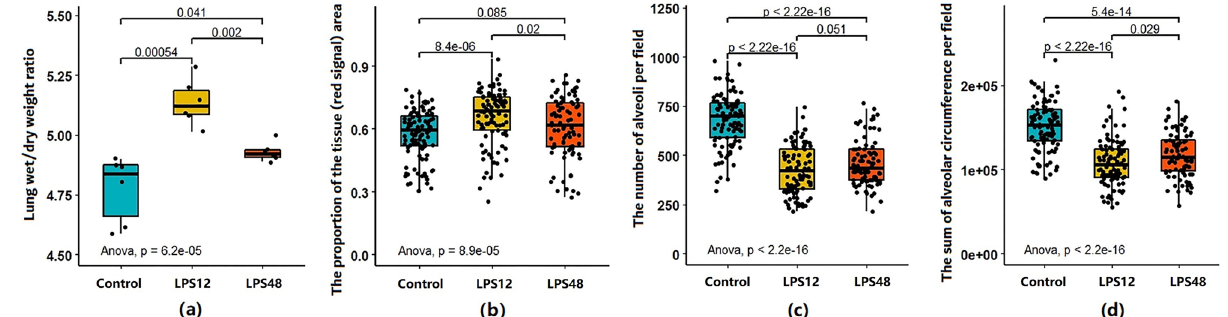
Figure 2. Changes in the wet/dry (W/D) ratio and quantified histological characteristics at indicated time points after LPS injection. ( a ) The W/D ratio was measured to estimate the level of pulmonary edema. ( b ) The proportion of the area of the tissue (red signal) representing the ratio of infiltration to air space was calculated for each screened image in order to quantify the level of interalveolar septum thickening. ( c ) The number of alveoli per field was calculated based on the recognition of the area of white signal in each screened image. ( d ) The sum of the alveolar circumferences was calculated based on the inner space peripheral length of each empty alveolus recognized by ImagePro Plus software version